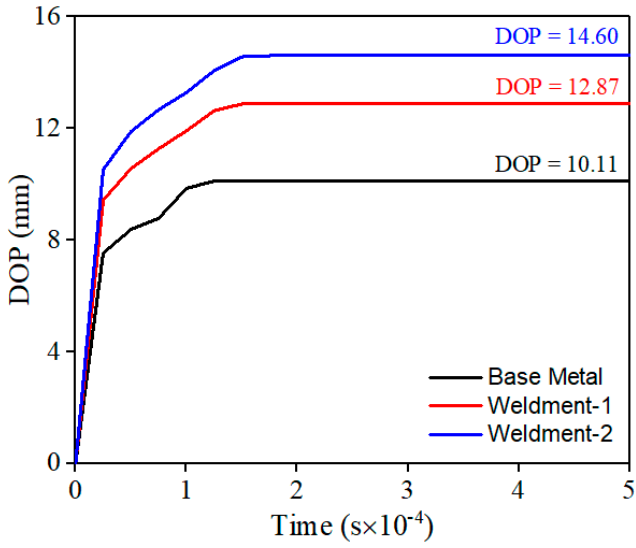
Figure 10. Depth of Penetration vs. Step time.